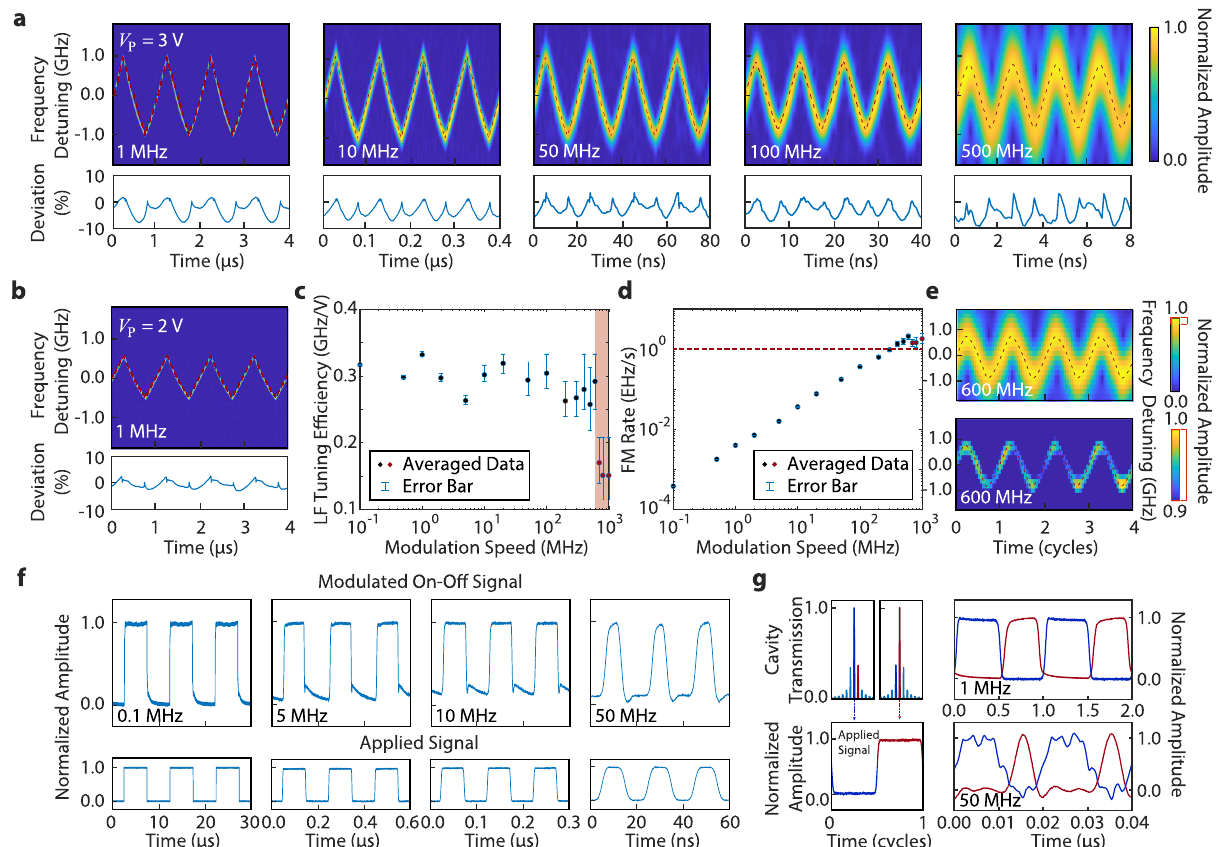
Fig. 3 | High-speed tuning and switching characteristics of the laser. a Time- ofSTFTathighfrequencycausedbythemeasurementsetuplimitation. d Recorded frequencyspectrogramsofthebeatnotebetweenthePockelslaserandareference laser frequency modulation rate. Red dashed line highlights the level of 1EHz/s. e Time-frequencyspectrogramofthebeatnotesignalwithamodulationfrequency diode laser, at different modulation frequencies. The red dashed lines show the triangular waveforms of the driving electrical signal (withanamplitudeof V P =3V) of 600MHz and a driving voltage of V P =3V. The lower one shows the same (The slight waveform distortion is induced by the limited bandwidth of a RF spectrogram but with a zoom-in amplitude range of 90 – 100%. f On-off intensity ampli fi er used to boost the electrical signal. See Methods for details). The lower switchingwaveformofthelaser(toprow)atdifferentmodulationfrequencies.The panel shows the deviation of signal compared to the modulating triangular ramp. corresponding driving electrical signal is shown in the bottom row, with an b Time-frequency spectrogram of the beat note with a smaller driving voltage of amplitude of V P =3V. g Left: Schematic shows the switching between adjacent V fi ciency of the laser fre- Vernier lasing mode in red and dark blue curve with the applied electrical signal P =2V. c The recorded laser-frequency (LF) tuning ef shown on the bottom. Right: Recorded waveforms of the two lasing modes, at a quency. The red shaded area indicates the frequency range beyond the photon modulation frequency of 1MHz and lifetime limit of the laser cavity. The error bars indicate the processing uncertainty